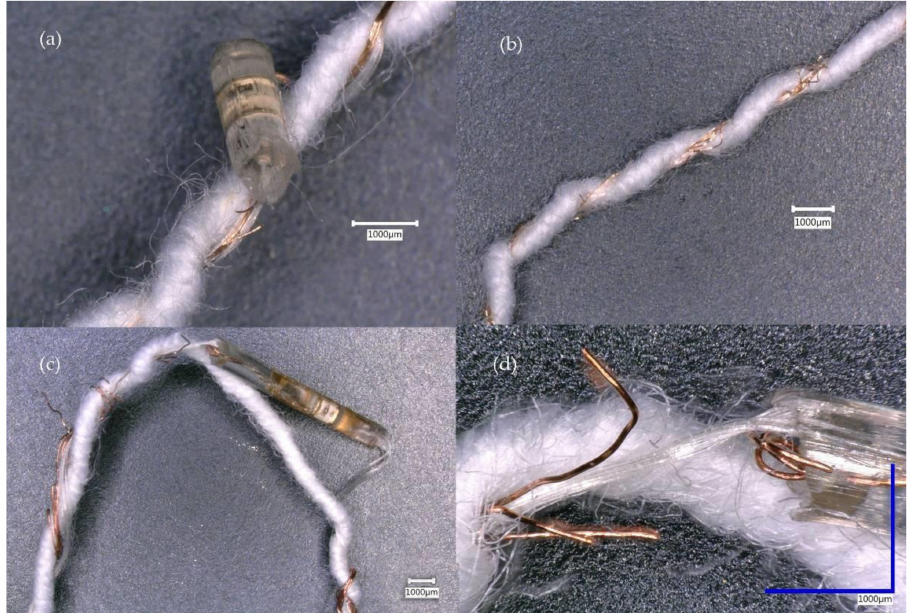
Figure 9. The interiors of illuminated E-yarns containing LEDs after failure during wash tests: ( a ) Copper wire severed from a micro-pod surrounding a package LED at 50X magnification; ( b ) Frayed copper wire at more than 50 mm from a package LED; ( c ) Copper wire severed from an encapsulated polyimide strip at 20X magnification; ( d ) A detailed view of ( c ) at 100X